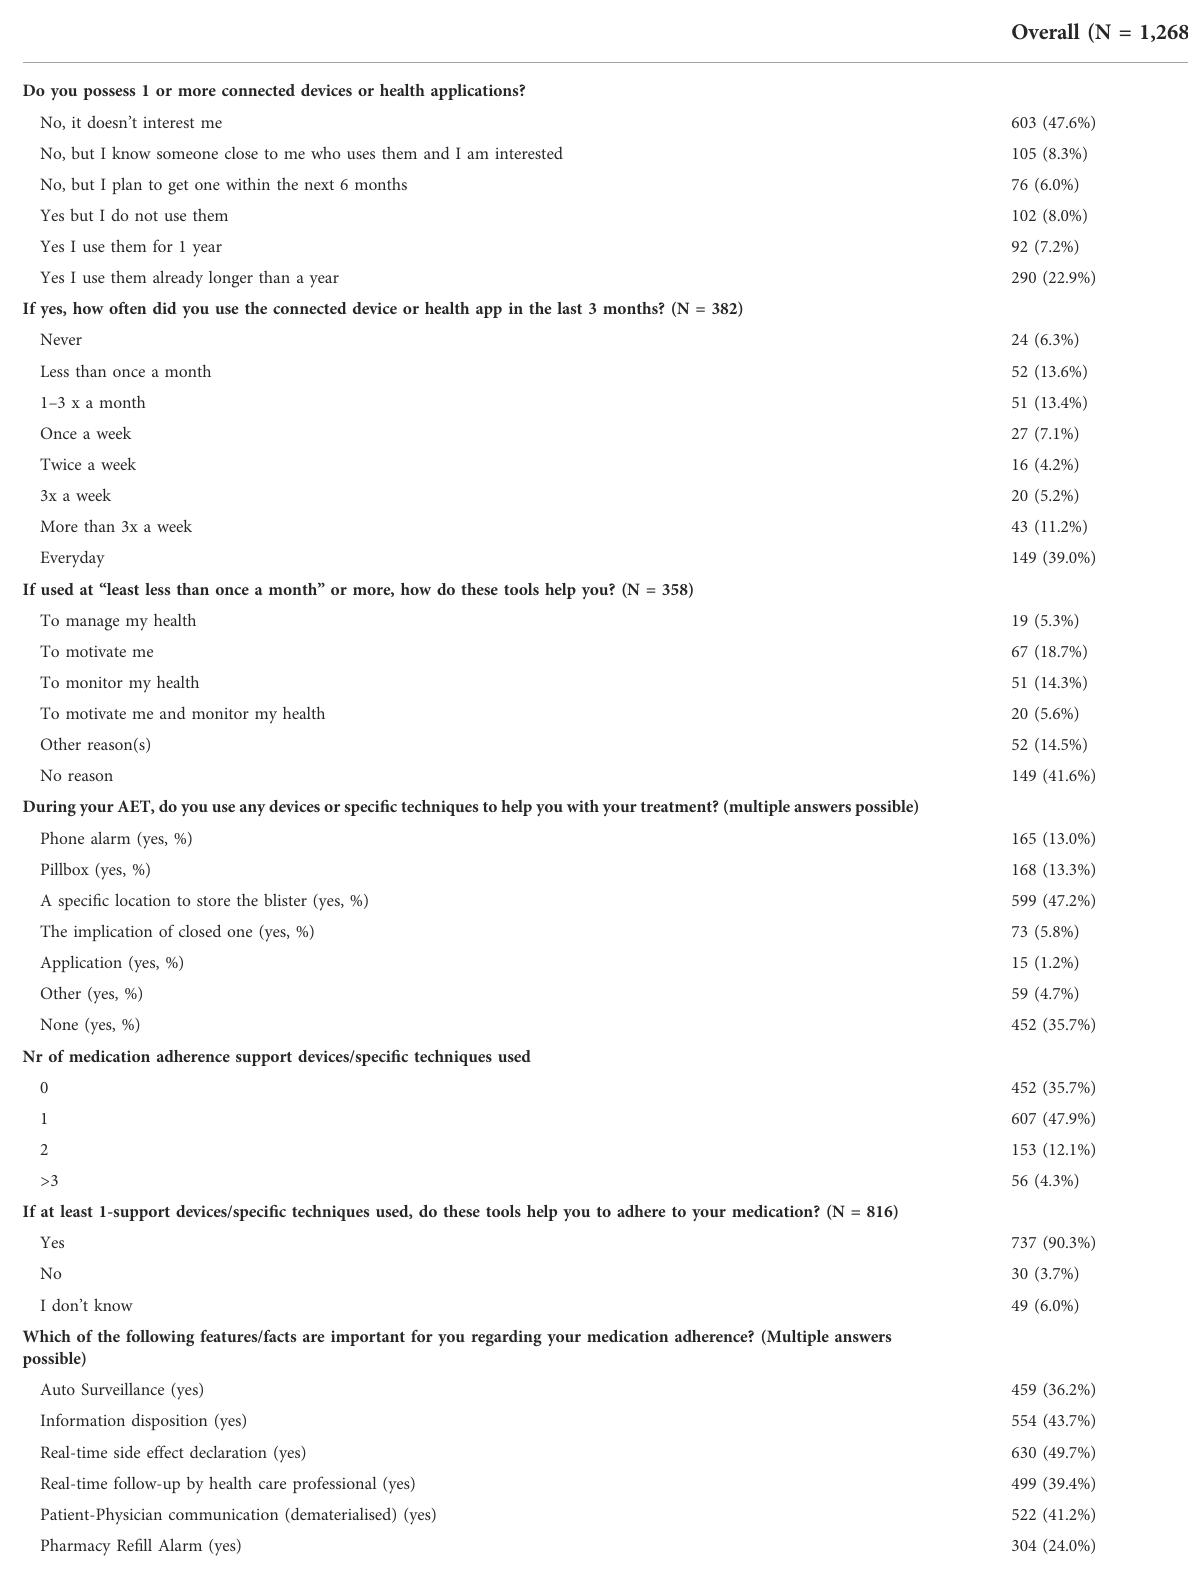
TABLE 2 Current eHealth use of BCS and acceptance to use a connected electronic blister with an app to manage AET (Seintinelles study,